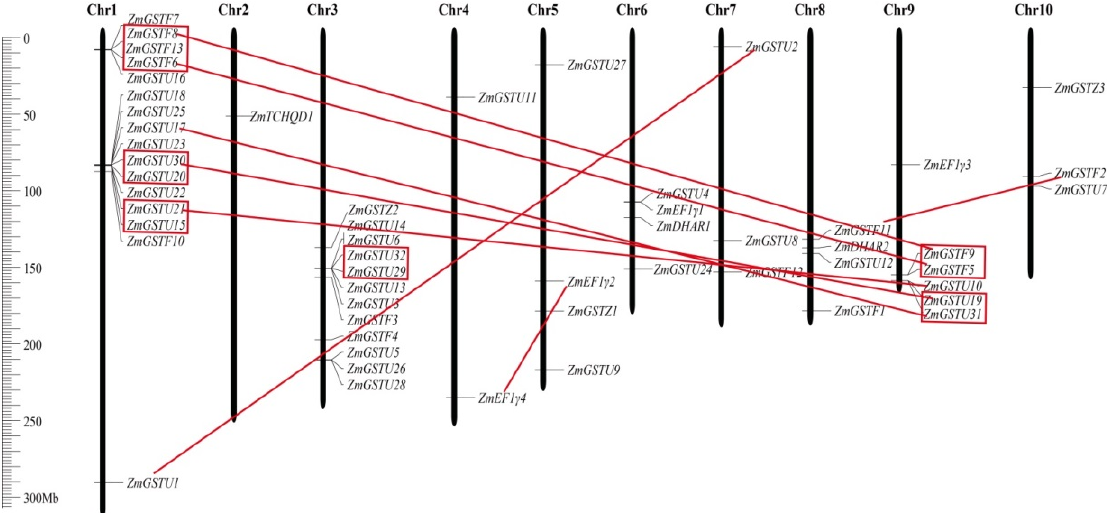
Figure 3. Chromosomal distribution of ZmGST genes in the Zea mays genome plotted using Mapchart software. Chromosome numbers were indicated on top of chromosomes, and the size of the chromosome was indicated by a vertical scale (Mb). Tandem duplicated genes were marked by red rectangles. Segmental duplicated gene pairs were connected with red lines.